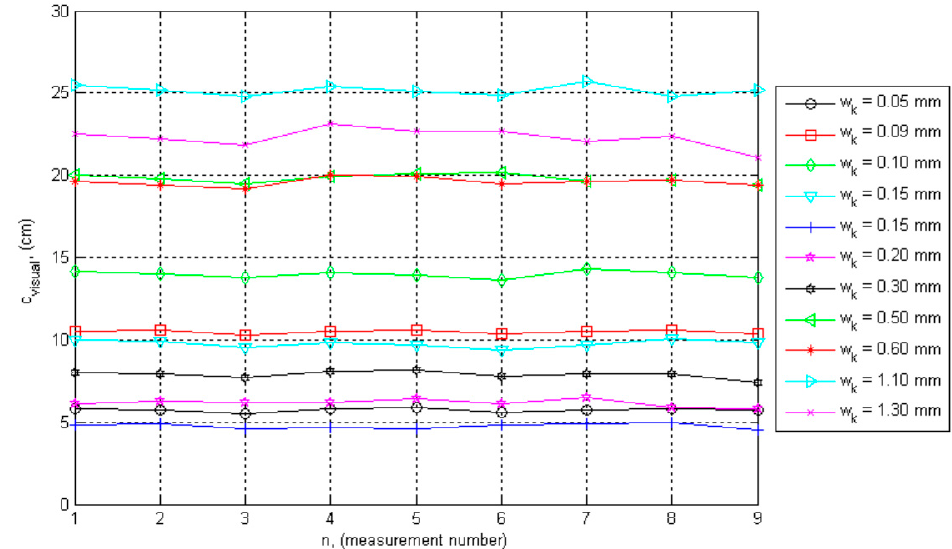
Figure 11. Crack depths determined by visual observation c visual for the corresponding crack widths.